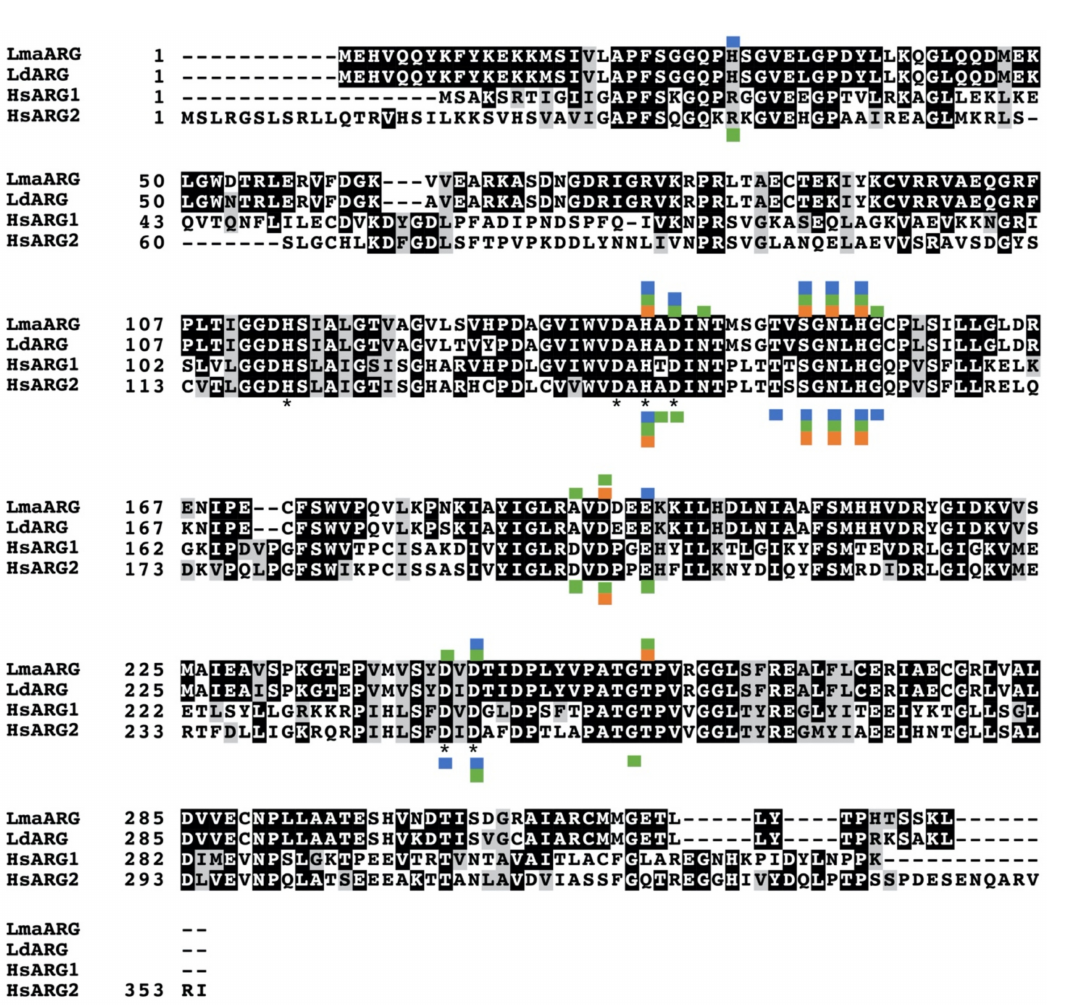
Figure 4. Sequence alignment of leishmanial and human arginases. LmaARG: L. mexicana amazonensis arginase, sequence ID AAC95287.1; LdARG: L. donovani arginase, sequence ID XP_003864734.1; HsARG1 Homo sapiens arginase 1, sequence ID NP_001231367.1; HsARG2: Homo sapiens arginase 2, sequence ID NP_001163.1. Sequences were aligned using the Clustal Omega tool. Residues in the multisequence file that were identical or similar between the four sequences were highlighted in black or grey, respectively, using Boxshade. Residues marked with the asterisk were identified as key sites from the first published report of the crystal structure of L. mexicana arginase [62]. Boxes above the sequence alignment denote residues where docking studies have indicated that inhibitors bind to leishmanial arginase, whereas boxes below the sequence alignment denote residues where inhibitors bind to host arginase (human or rat). Blue boxes designate sites where flavonols bind (quercetin and fisetin), green boxes show sites where green tea components bind (C, EC, ECG, and GA), and orange boxes indicate sites where cinnamic acids bind (caffeic acid, rosmarinic acid, and chlorogenic